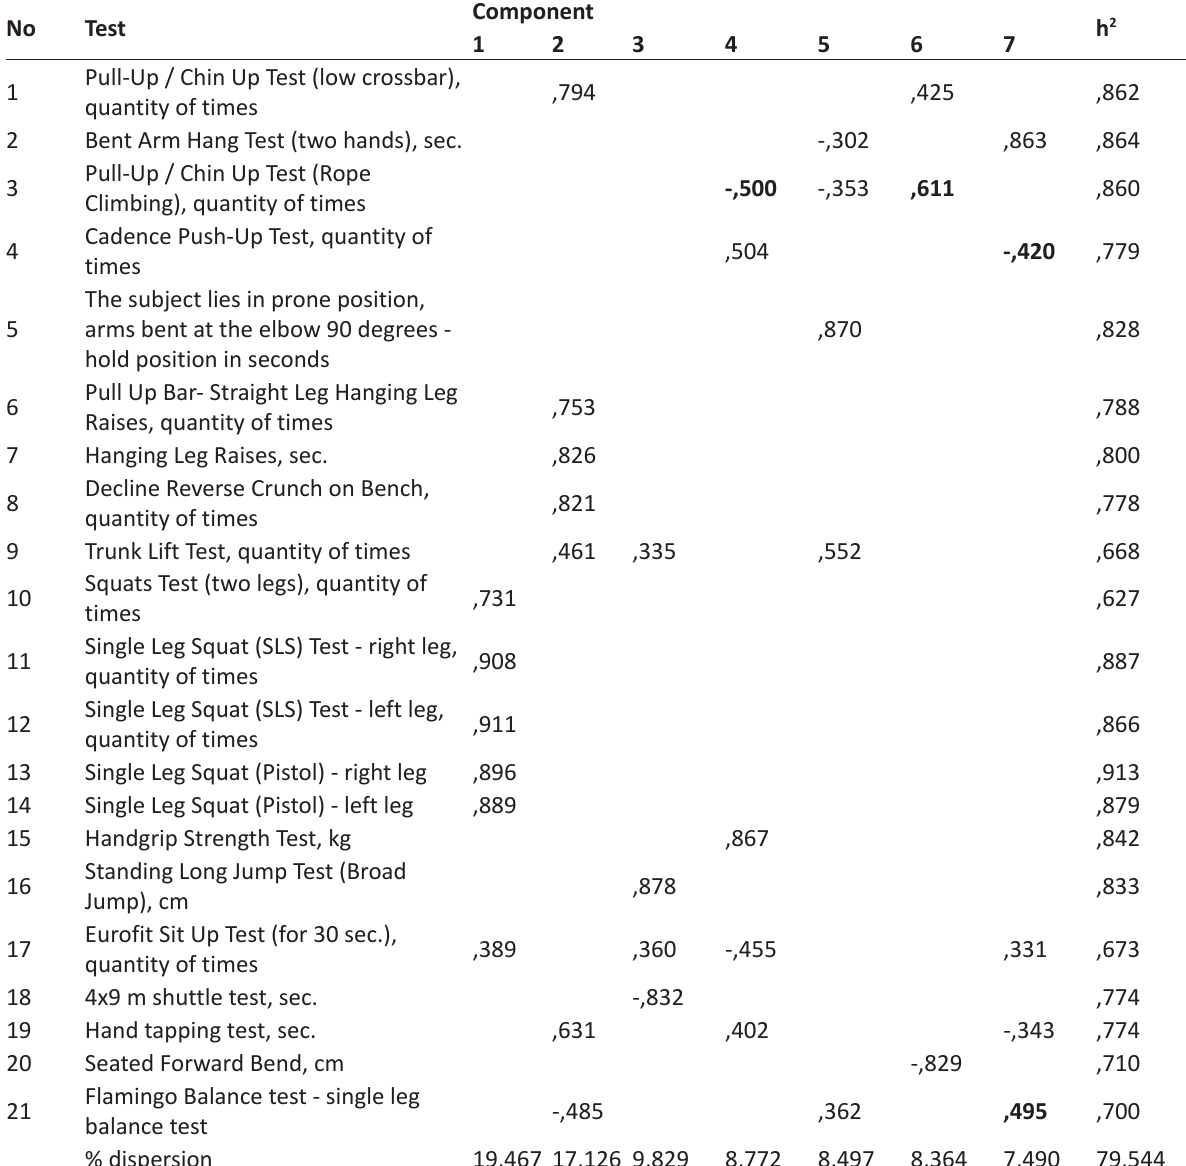
Table 3. Factor structure of motor preparedness of the girls 14 years old. Method: principal component analysis. Rotation method: Varimax with Kaiser Normalization (n =